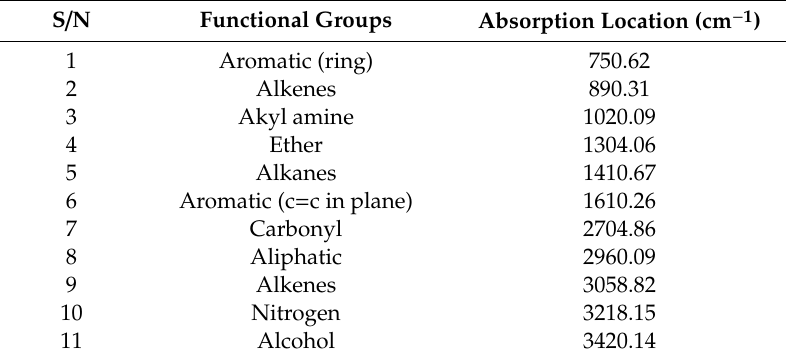
Table 2. Pyrolytic oil functional groups.